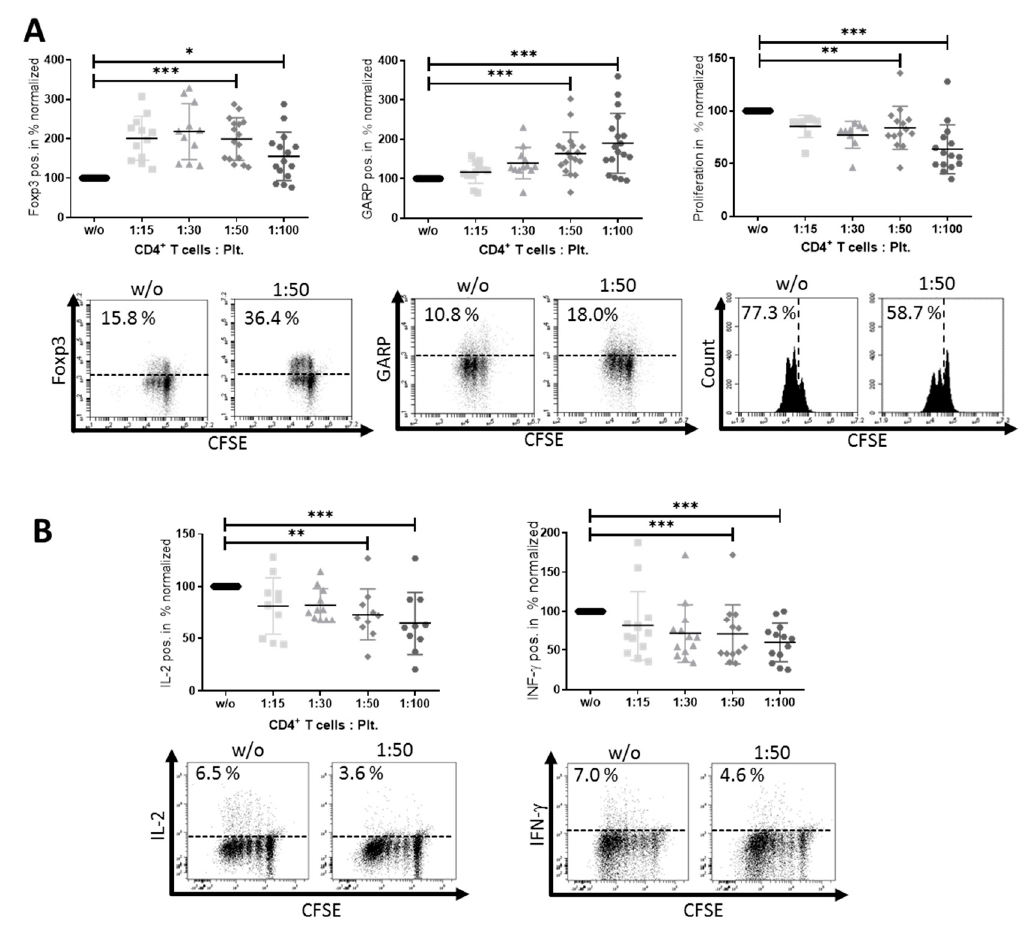
Figure 2. Platelets induce peripheral regulatory T cells (iTreg). ( A ) CD4 + CD25 − T cells and platelets were cocultured as indicated. Herein, carboxyfluorescein succinimidyl ester (CFSE)-labeled CD4 + CD25 − T cells were stimulated with 0.5 µg/mL anti-CD3 mAb and 1.0 µg/mL anti-CD28 mAb with or without different ratios of platelets. The expression of Foxp3, GARP and the proliferation of cells were analyzed via flow cytometry on day 3 after stimulation. ( B ) Effector cytokine production of Interferon(IFN)- γ and interleukin (IL)-2 was analyzed using intracellular flow cytometry on day 6. Only live CD4 + CD25 − T cells were included into the analysis. Representative dot plots of 12 independent experiments are shown. The graphs show cells cultured in the presence of platelets normalized to CD4 + CD25 − T cells without platelets (expression levels were normalized to 100) ( n = 12, means ± SD, * p < 0.05, ** p ≤ 0.01, *** p ≤ 0.001, and n.s. determined by Kruskal–Wallis test).